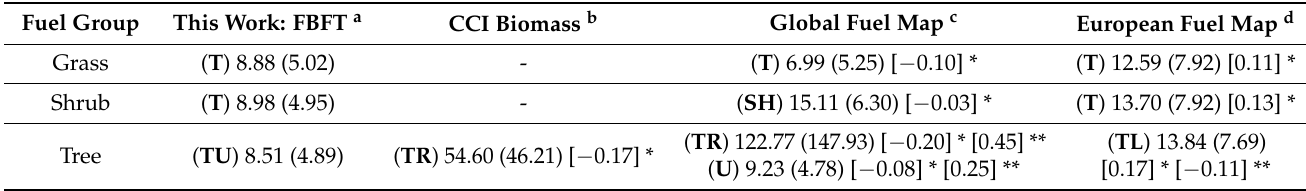
Table 5. Mean and standard deviation (in parenthesis) biomass (in Mg/ha) of fuel groups (Table 4 in the Appendix A). Spearman’s rank correlation (in brackets) is used to compare this work with other products.